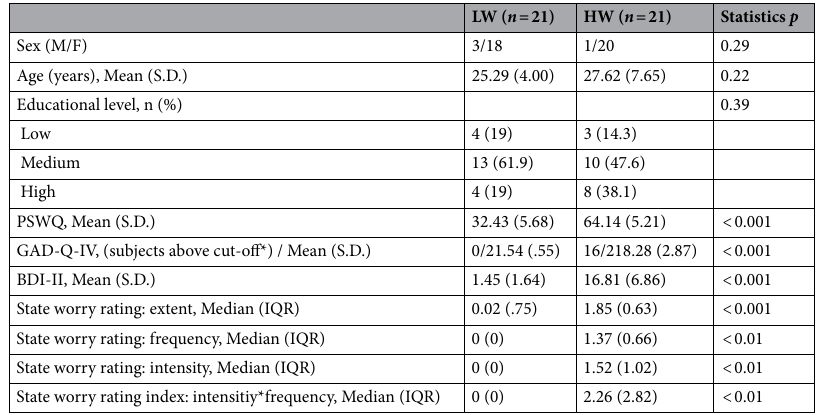
Table 1. Subjects’ sociodemographic, clinical and state worry data. BDI-II beck depression, F female, GAD- Q-IV generalized anxiety disorder questionnaire-IV, HW high worriers, IQR interquartile range, LW low worriers, M male, PSWQ penn state worry questionnaire, S.D. standard deviation. *A score above the cut-off is indicative of a GAD